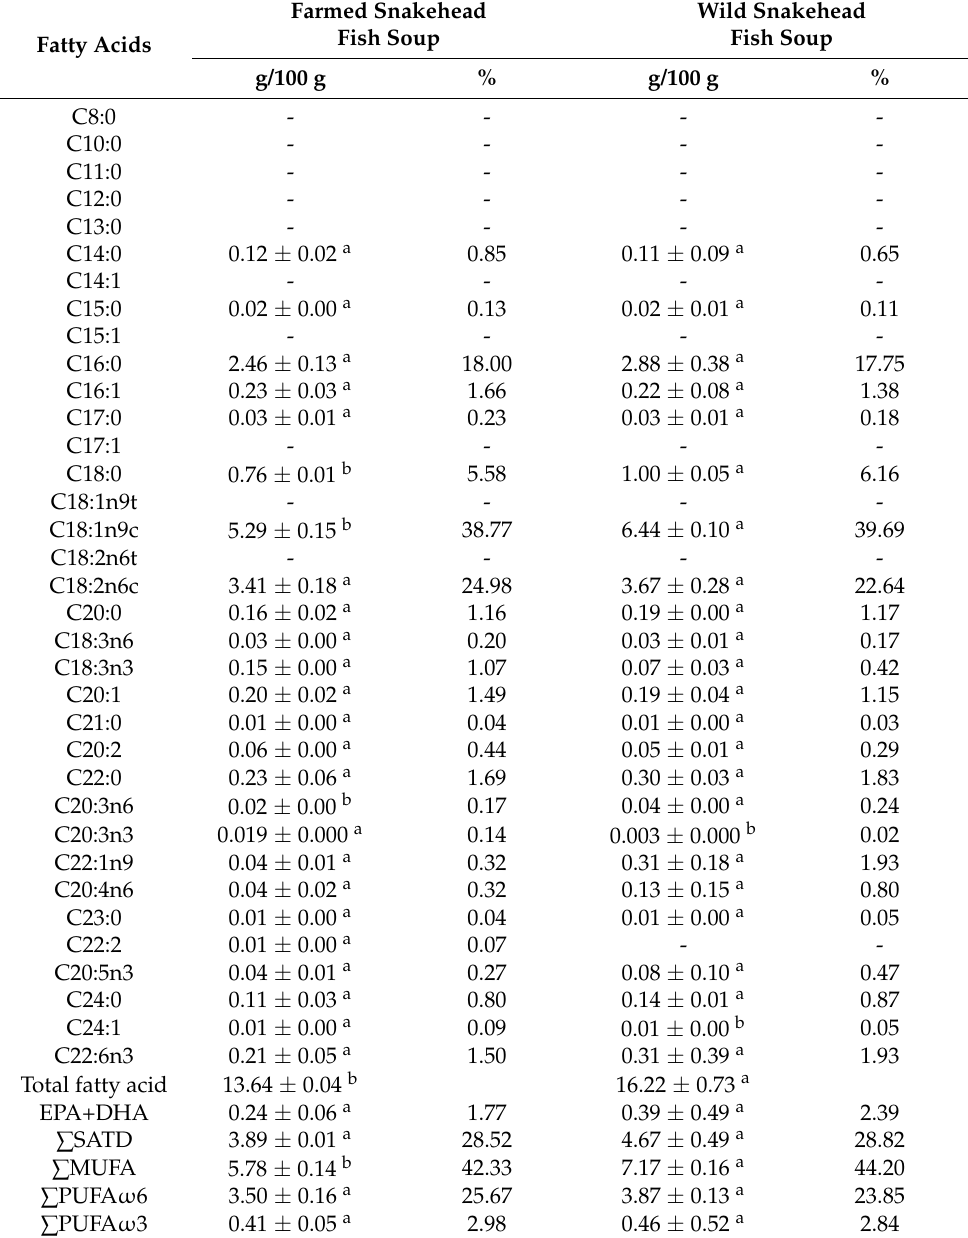
Table 4. Fatty acid composition in soup made from farmed and wild snakehead fish.